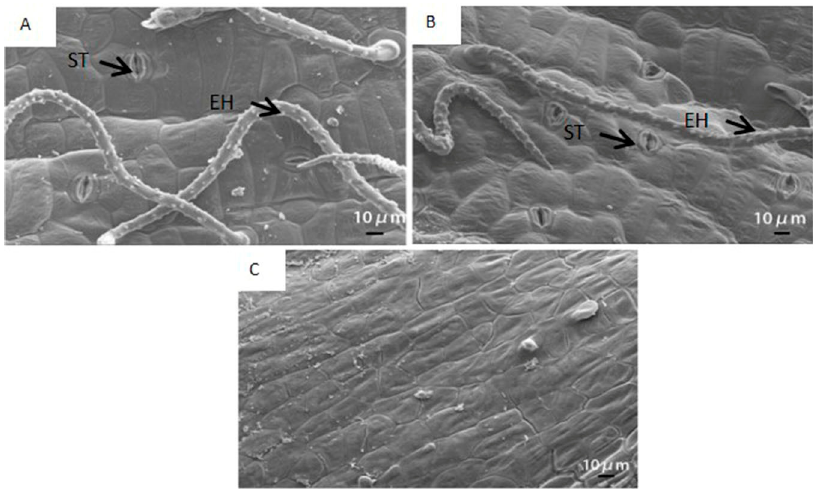
Figure 1. The scanning electron micrograph of the outer ( A , B ) and the inner surface ( C ) of the pod wall on the 10th day after pollination (DAP10) under well-watered ( A ) and water-stressed treatments ( B ). ST, stoma; EH, epidermal hair; D, dots; H, hump.